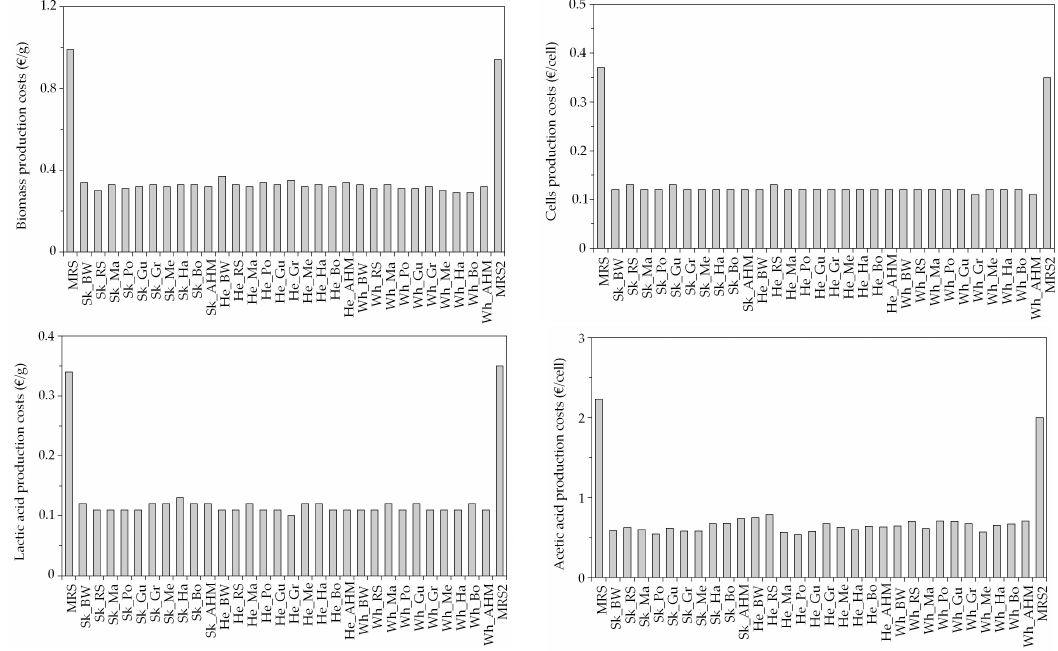
Figure 3. Economical evaluation of Lb 1 bioproduction costs in the culture media studied.